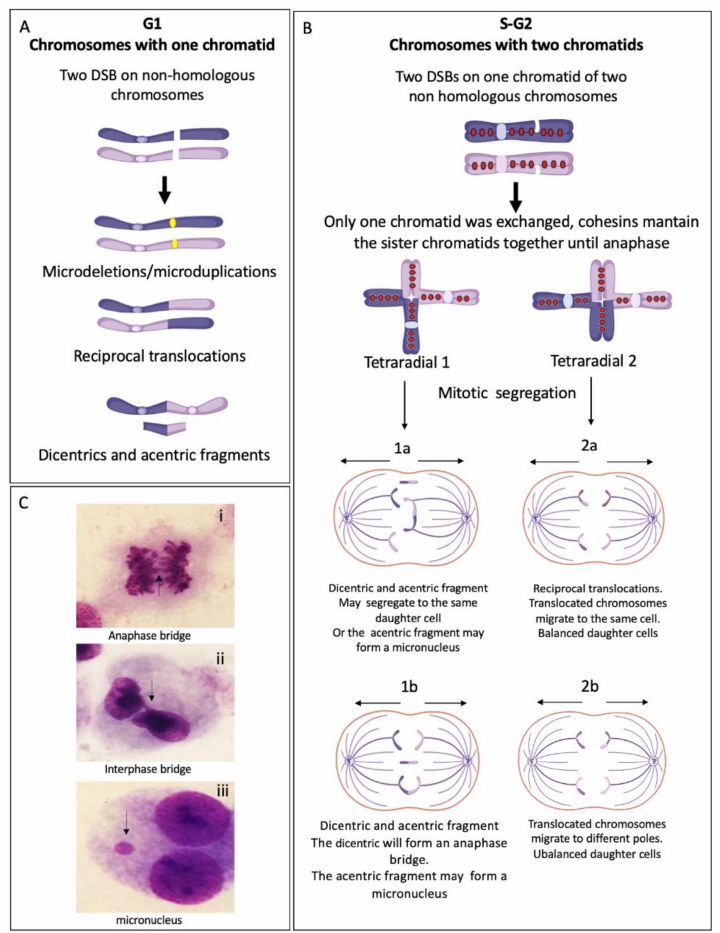
Figure 4. End joining repair pathways outcomes when more than one DSB is present in the same space-time and the rejoining is between non-homologous chromosomes. ( A ) G1 chromosomes have only one chromatid. When two chromosomes have DSBs, repair by NHEJ and MMEJ can perform the reunion of the two original chromosomal fragments, without error or leaving microdeletions or microduplications. If two fragments from di ff erent chromosomes are joined, translocations or dicentrics + acentric fragments are generated. ( B ) S / G2 chromosomes have two sister chromatids linking each other by cohesins. If only one sister chromatid has a DSB, the interchange of segments during repair generates gross structural aberrations such as translocations or radial figures, which may have